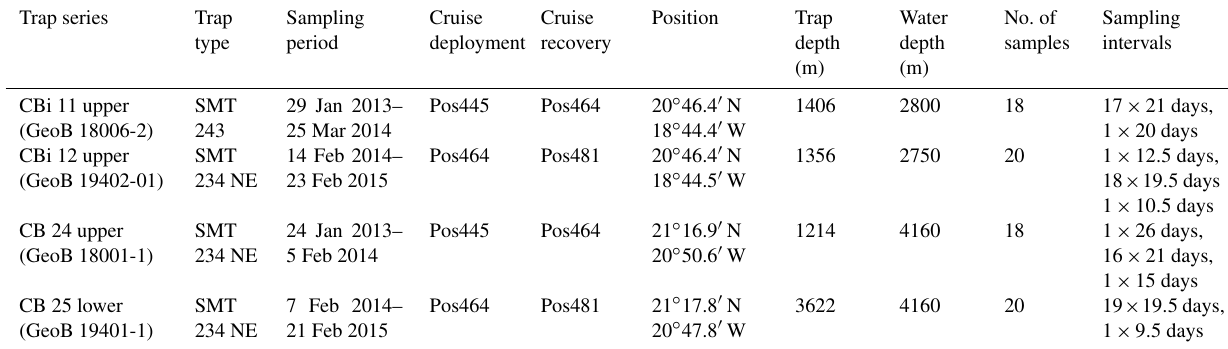
Table 2. Specifications of the sediment trap samples collected during 2013–2015 chosen for flux and grain-size analysis. Trap